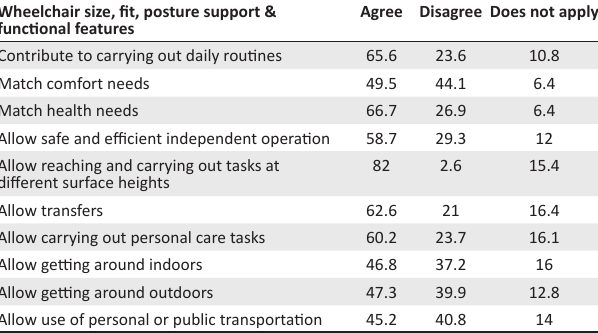
TABLE 3: Functioning every day with a wheelchair (FEW) scores ( n = 94). Wheelchair size, fit, posture support & functional features